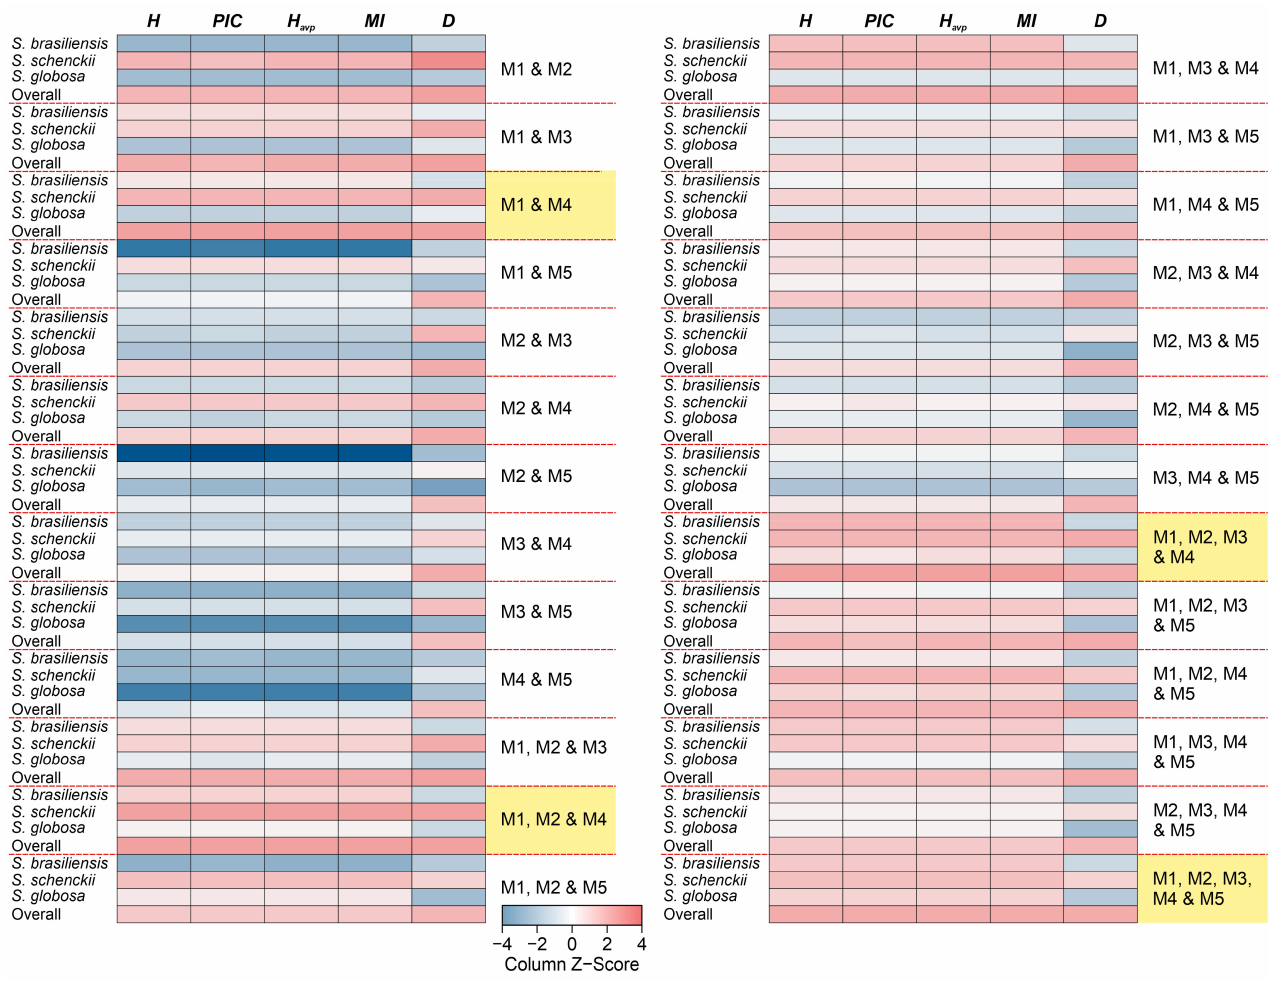
Figure 5. Multiplex combinations were used to assess intra and interspecific diversity in medically relevant Sporothrix, revealing that a minimum of three multiplexes (nine SSR markers) are needed to cover considerable diversity in Sporothrix . In order of effectiveness, our recommendations are (1) M1, M2, M3, M4, and M5; (2) M1, M2, M3, and M4; (3) M1, M2, and M4; and (4) M1 and M4. Clustering patterns in S. schenckii follow a geographic trend as observed for clades IIa (n = 16, Dice similarity = 58.07% ± 6.05%), IIb (n = 11, Dice similarity = 58.90% ± 4.13%), IIc (n = 5, Dice similarity = 40.46% ± 0.37%), and IId (n = 11, Dice similarity = 60.40% ± 4.31%). Most clades (IIa–IIc) are composed of isolates recovered in Latin America, while clade IId harbors global specimens represented by Brazil, USA, Italy, and Mexico. In S. glo- bosa , four clades with limited diversity were observed being named IIIa (n = 5, Dice similarity = 67.86% ± 2.59%), IIIb (n = 12, Dice similarity = 73.09% ± 6.09%), IIIc (n = 10, Dice similarity = 76.32% ± 1.59%), and IIId (n = 4, Dice similarity = 76.32% ± 1.59%). We highlight clade IIIc with closely related samples from Brazil, Chile, Spain, Venezuela, and Japan (Supplementary Figure S3). Dice similarity coefficient values for the SSR markers indicated that diversity is high for the Sporothrix genotypes (Figure 6). The observed clus- tering patterns indicate that S. brasiliensis and S. schenckii are sister species, and S. globosa assumes a more basal position within the clinical